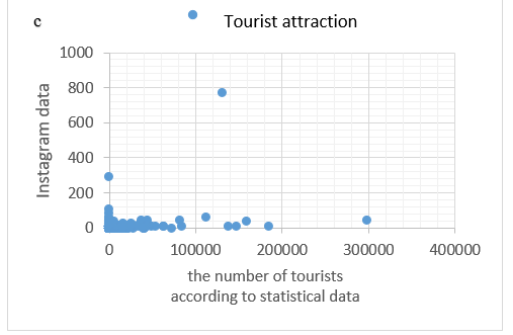
Figure 4.5 Visual graphic with tessellation size (a) 1 Km; (b) 1,25 Km; and (c) 2Km